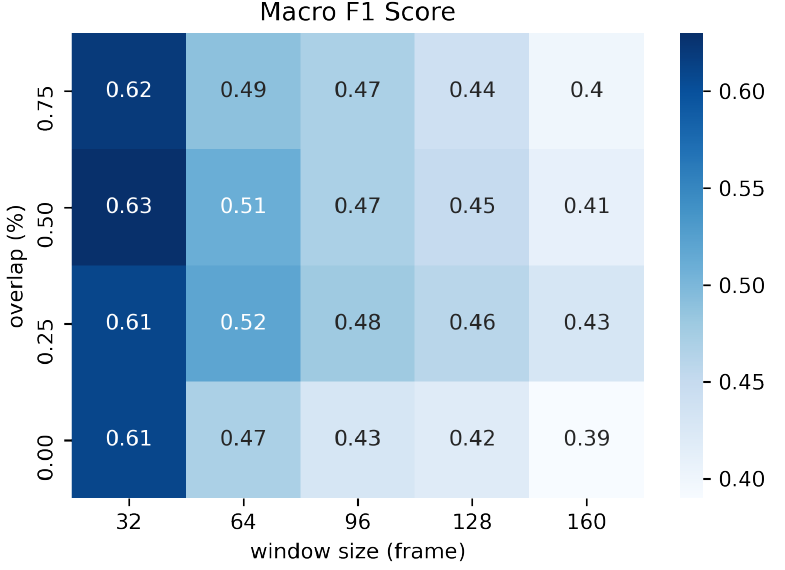
Figure 7. Heatmap of macro average F1-score of overlap vs. window size. All offline meeting datasets are used. The unit for window size is by frame. The unit for overlap is by